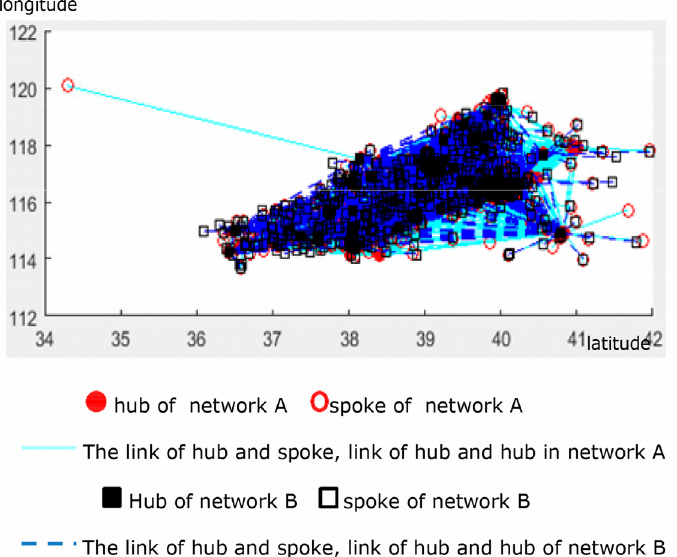
Figure 5. Two overlapping hub- and-spoke network of A and B in the northern region r = 1,  = 15